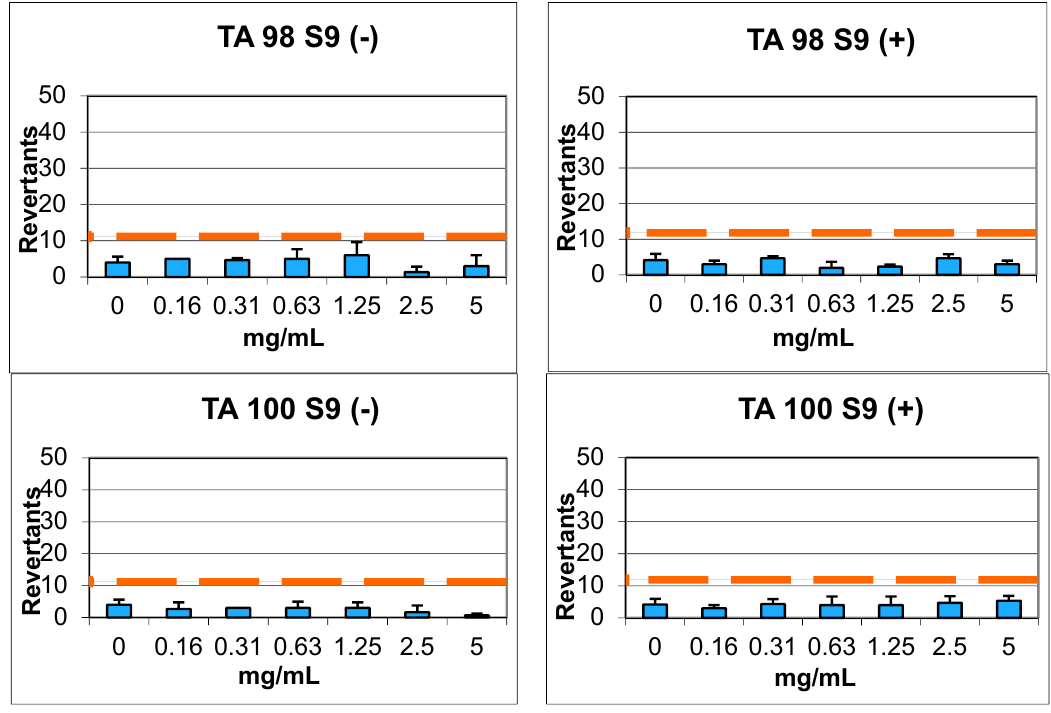
Figure 6. Ames MPF test results of compound 9 against TA98 and TA100 with/without S9.